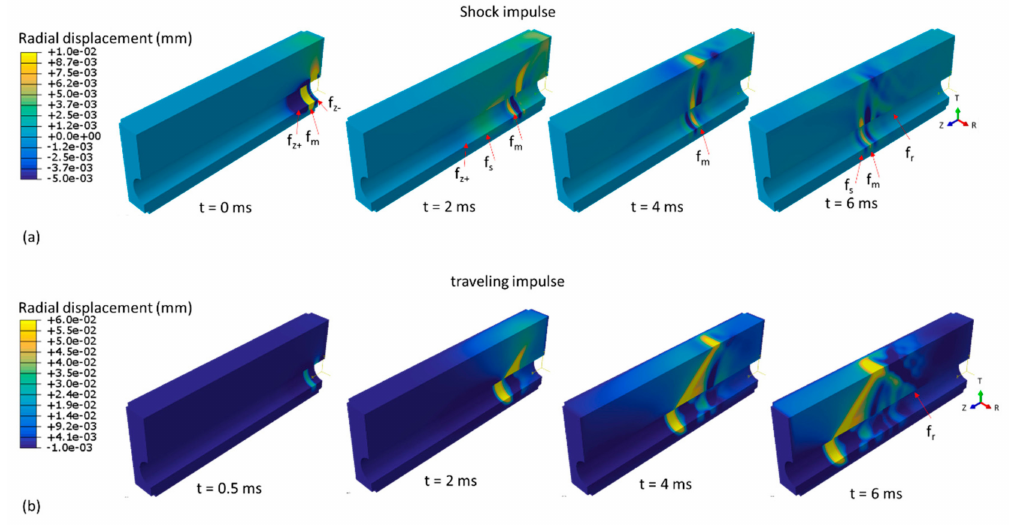
Figure 4. Radial displacement in the common carotid artery (CCA) model depicting wave propagation at four time instances for ( a ) shock impulse and ( b ) traveling impulse with a velocity of 7 m / s. Note that a cylindrical coordinate system is used in this figure to obtain a more intuitive visual representation of wave propagation. See text for a description of the observed and indicated